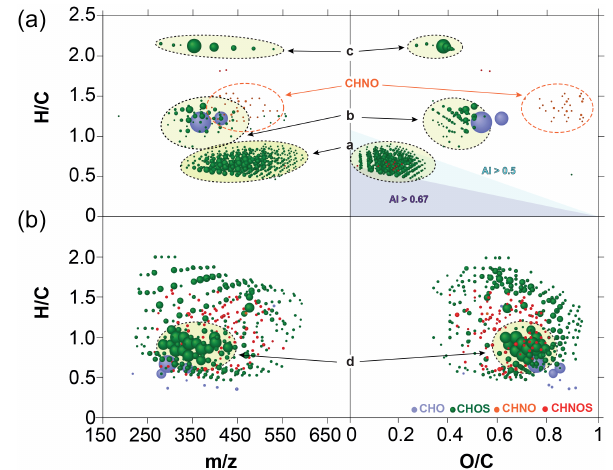
Figure 9. Comparative analysis of (left) H / C vs. m/z and (right) H / C vs. O / C van Krevelen diagrams derived from negative elec- trospray 12T FTICR mass spectra of the two Florida Coastal Ever- glades SPE-DOM FCE-S and FCE-L (see also Fig. 8). (a) Molecu- lar compositions with high abundance in Florida Coastal Everglades SPE-DOM FCE-S; section (a): oxygen-deficient (poly)aromatic black sulfur; CHNOS: suite of highly oxygenated CHNOS molecules; section (b): common CHOS molecules in DOM; sec- tion (c): saturated sulfolipids. The aromaticity index AI (Koch and Dittmar, 2006) provided in the upper right van Krevelen diagram de- notes single aromatic compounds for AI>0.5 (bright blue triangle) and polyaromatic compounds for AI>0.67 (bright purple triangle); (b) Molecular compositions with high abundance in Florida Coastal Everglades SPE-DOM FCE-L; section (d): a distinct set of oxygen- rich aromatic CHOS compounds, likely associated with ether-linked aromatic units; see main